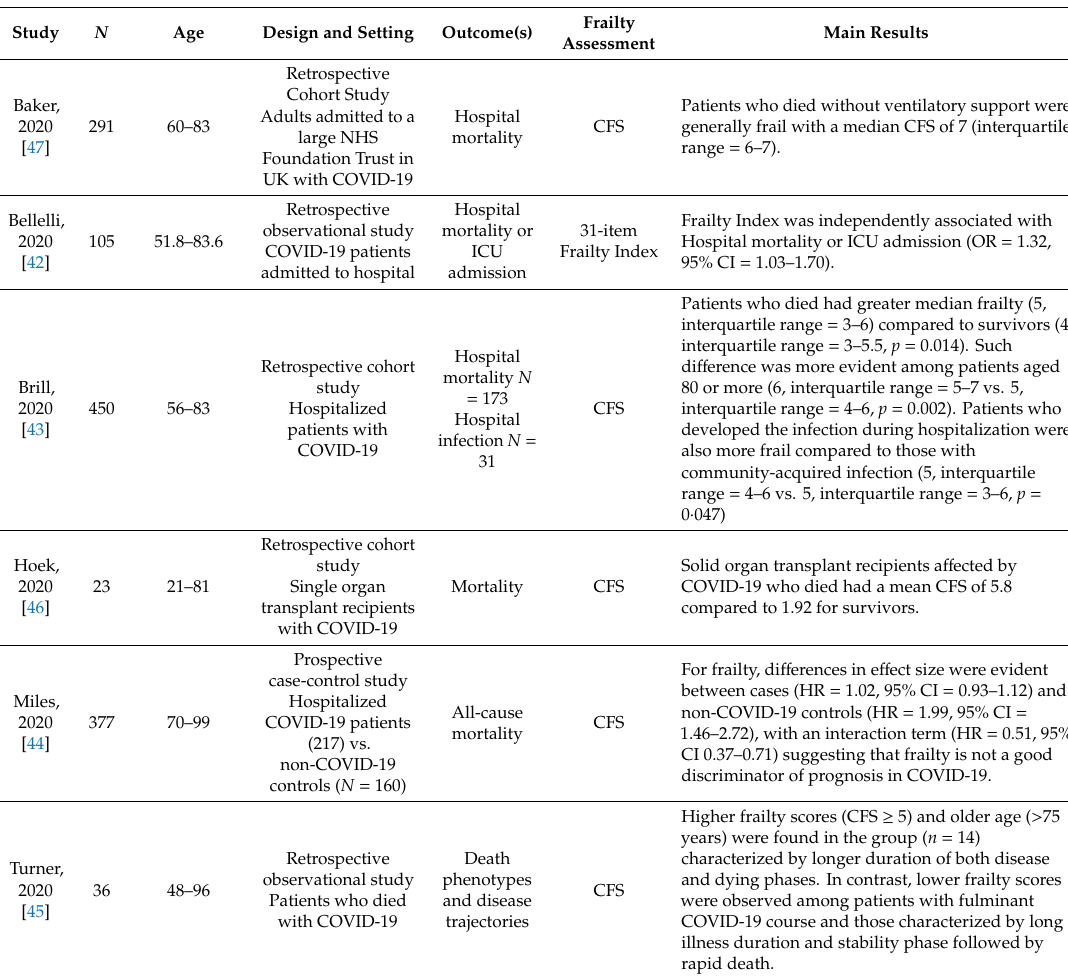
Table 1. Summary of findings from retrieved